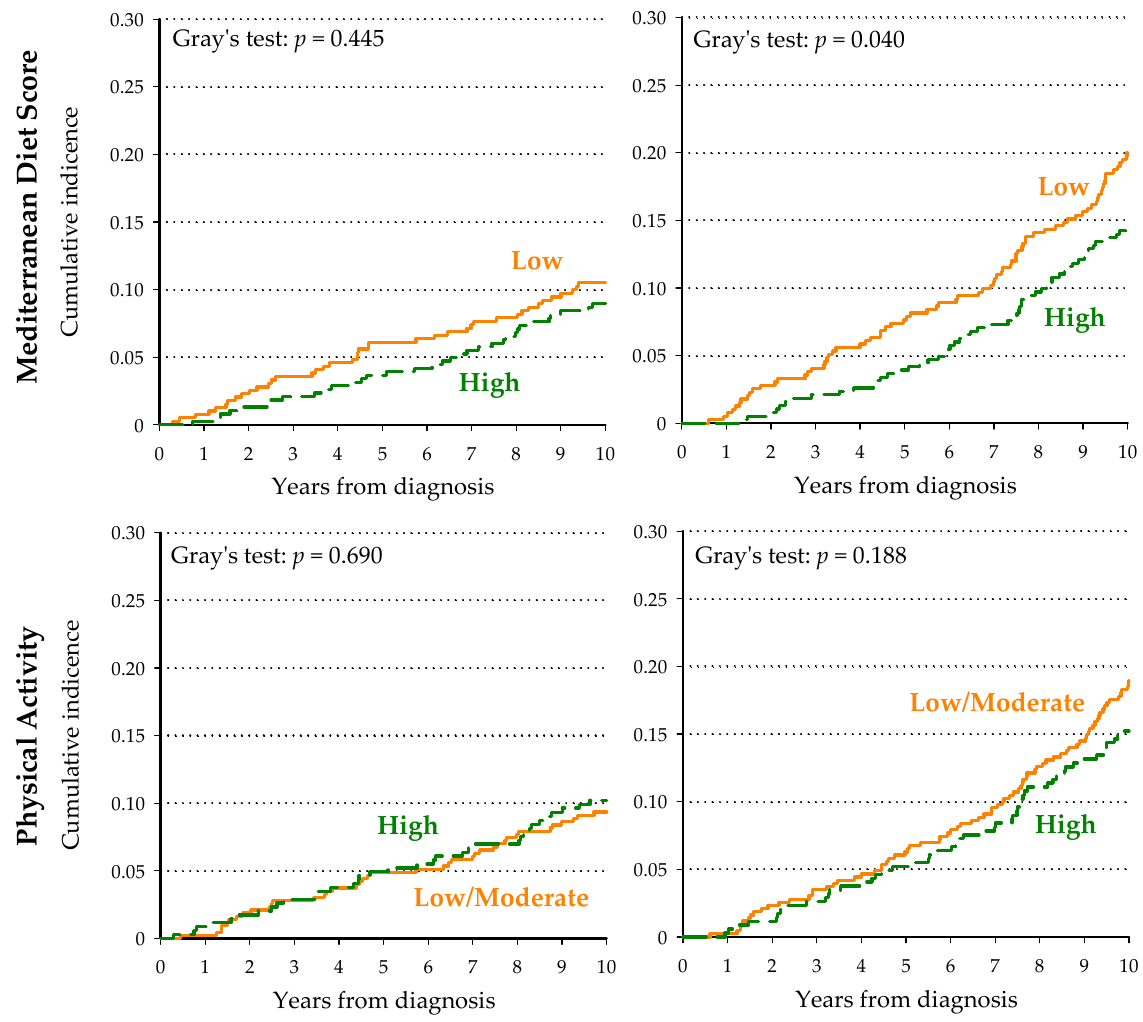
Figure 2. Cumulative incidence of prostate cancer and non-prostate cancer death among 777 men diagnosed with prostate cancer, according to Mediterranean Diet Score and physical activity.